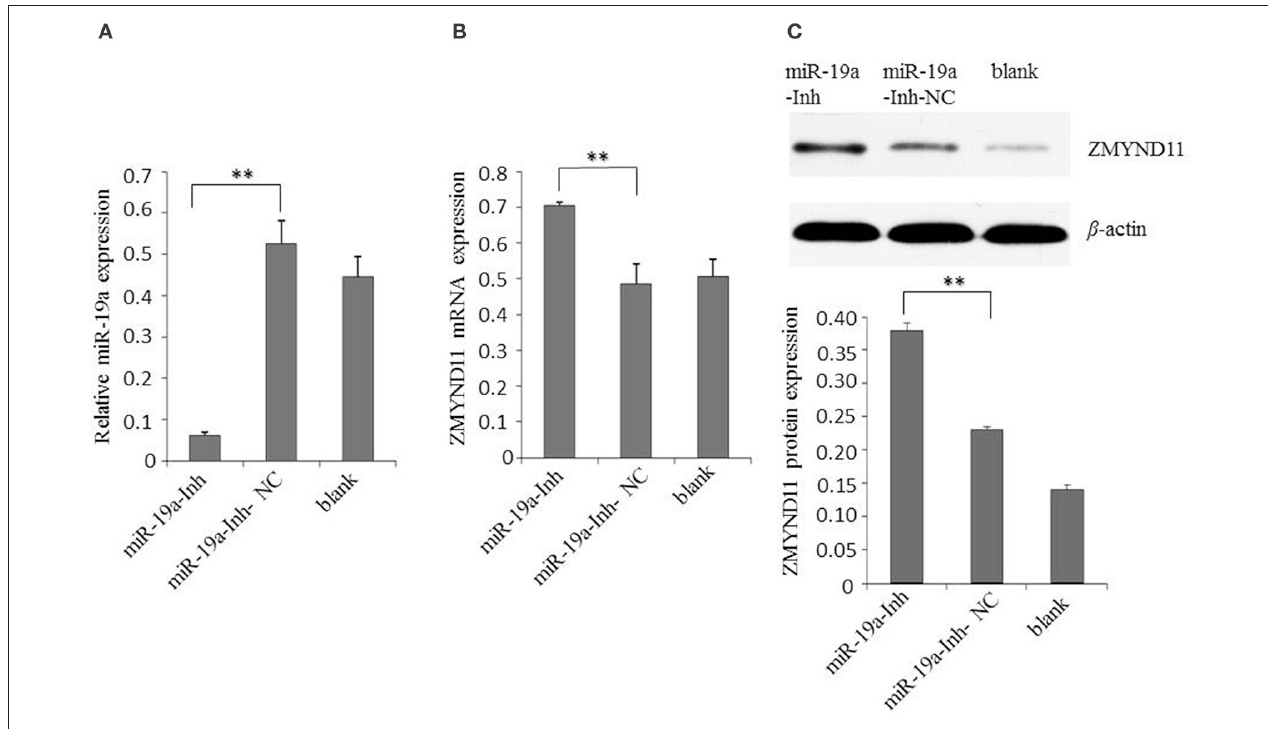
FIGURE 4 | Inhibition of gga-miR-19a increases ZMYND11 expression. (A) Transfection of miR-19a-Inh reduced the expression of gga-miR-19a in DF-1 cells; (B) Transfection of miR-19a-Inh increased the expression of ZMYND11 in DF-1 cells; (C) Western blot was performed to analyze ZMYND11 protein expression in DF-1 cells at 48 h post-transfection with miR-19a-Inh. A mock transfection was used as the blank; the expression of GAPDH was used as a loading control. All values are represented as the mean ± SD of three independent experiments in triplicate. Significant differences are denoted as ** P < 0.01.